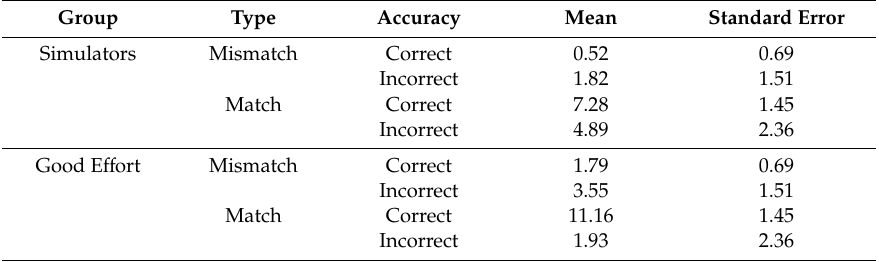
Table 2. Effect of Group, Stimulus Type, and Accuracy on Mean P3 Amplitude at Pz.